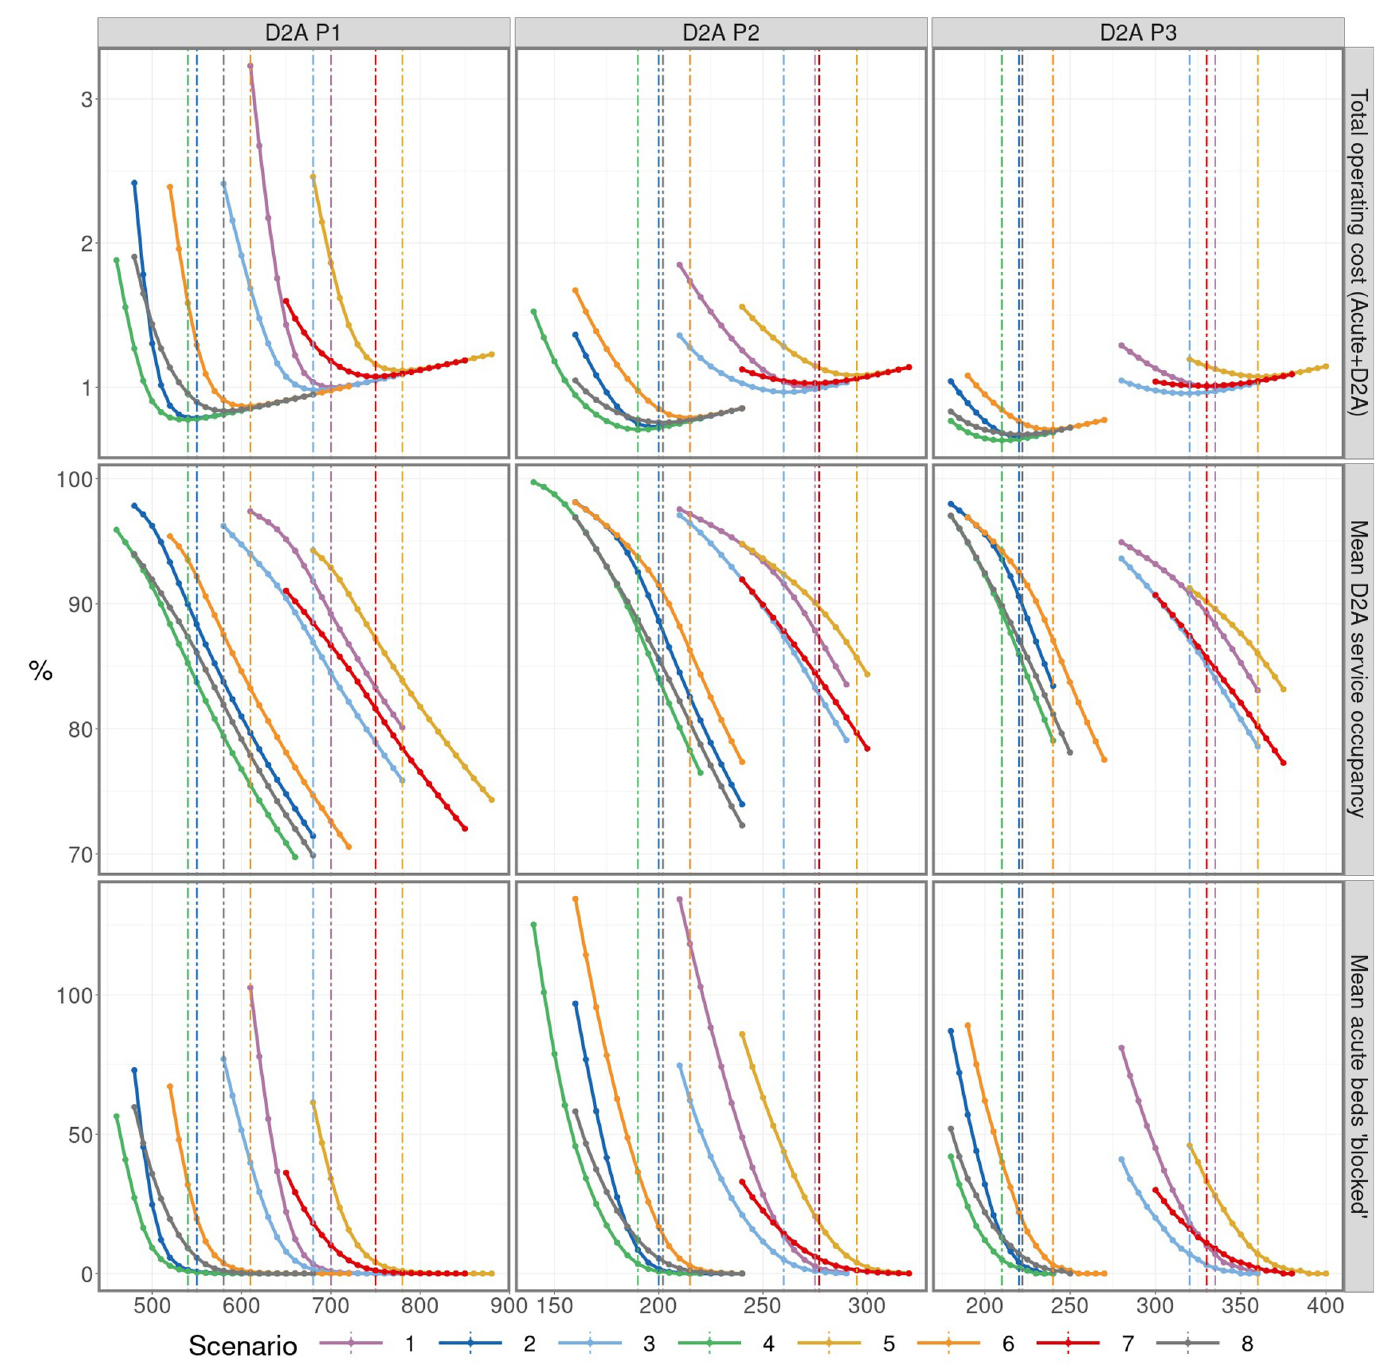
Fig 3. Simulated results for total operating cost of D2A service and acute delays (indexed on baseline); mean D2A service occupancy, expressed as a percentage of total capacity; and mean number of acute beds ‘blocked’ (i.e. acute patients whose discharge is delayed due to insufficient D2A service capacity). Simulations were performed over the period 14 May 2021 to 31 December 2021 for each of the three D2A pathways for a range of considered service capacities and scenarios (Table 1). Dashed vertical lines highlight the results corresponding to the cost-optimal capacity, as determined by the lowest total weekly